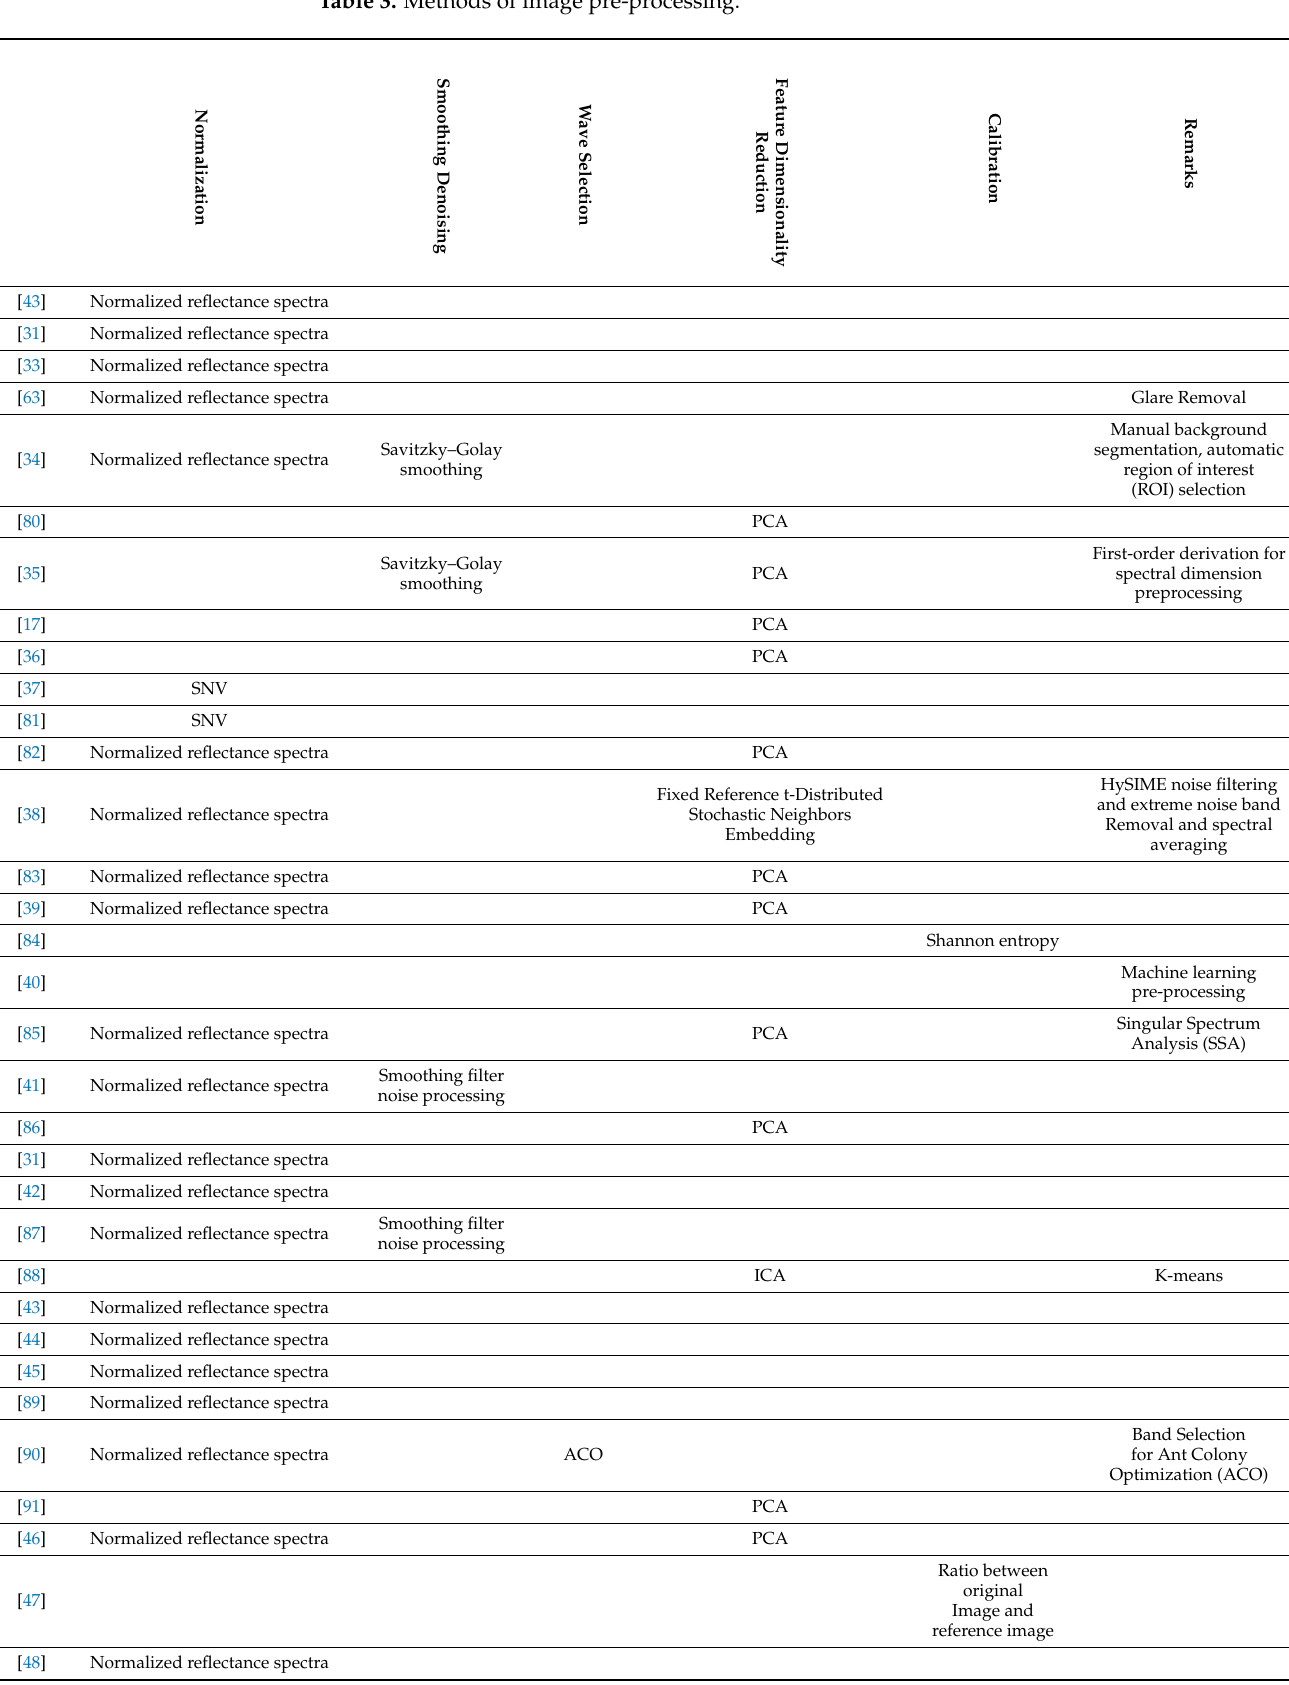
Table 3. Methods of image